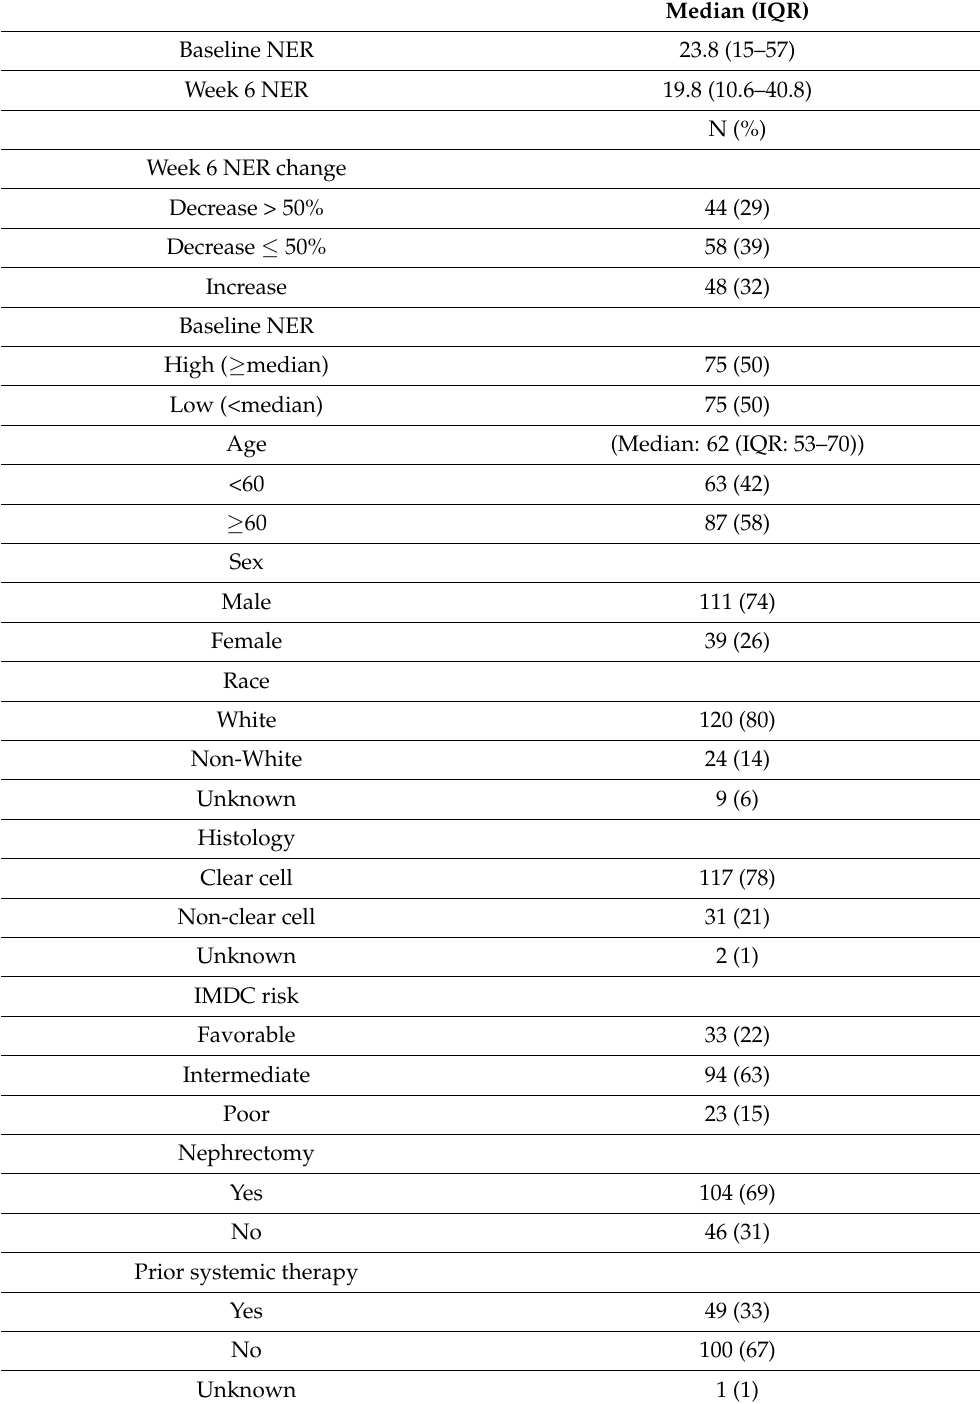
Table 1. Patient baseline characteristics (N =